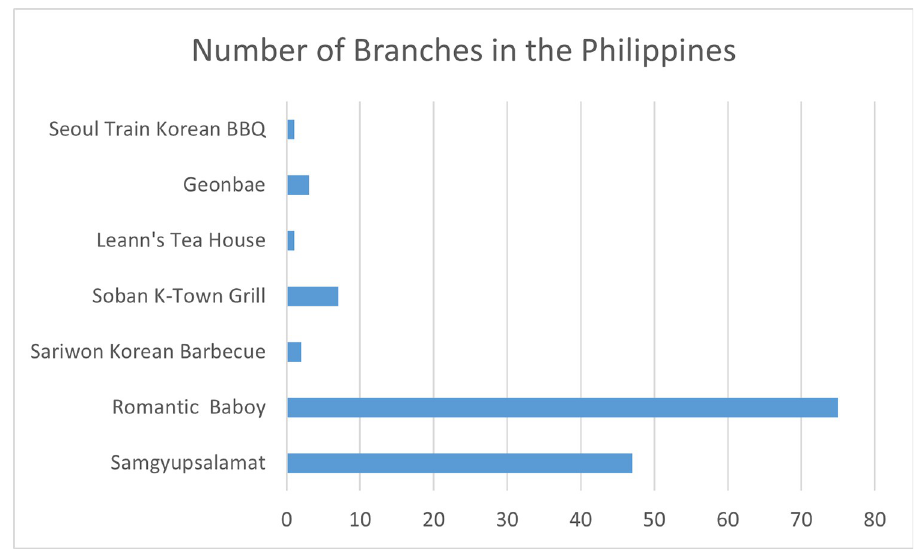
Fig 1. Number of Samgyeopsal branches of seven restaurants in the country